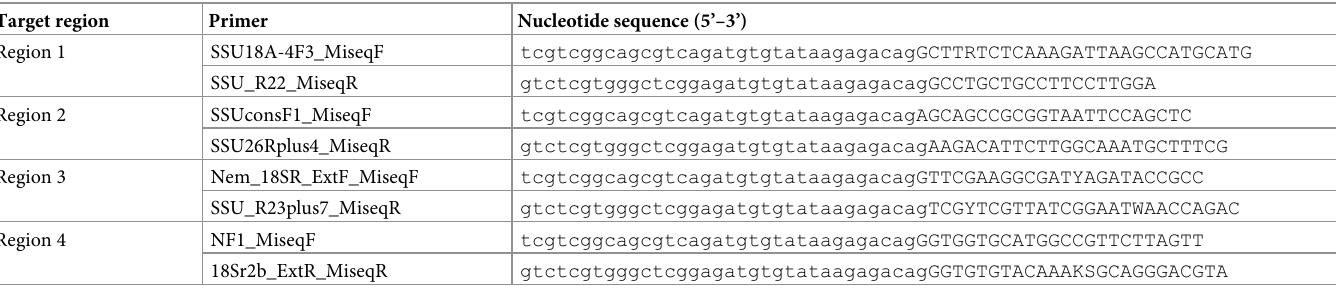
Table 1. PCR primers used for amplification of four regions of 18S rRNA gene.